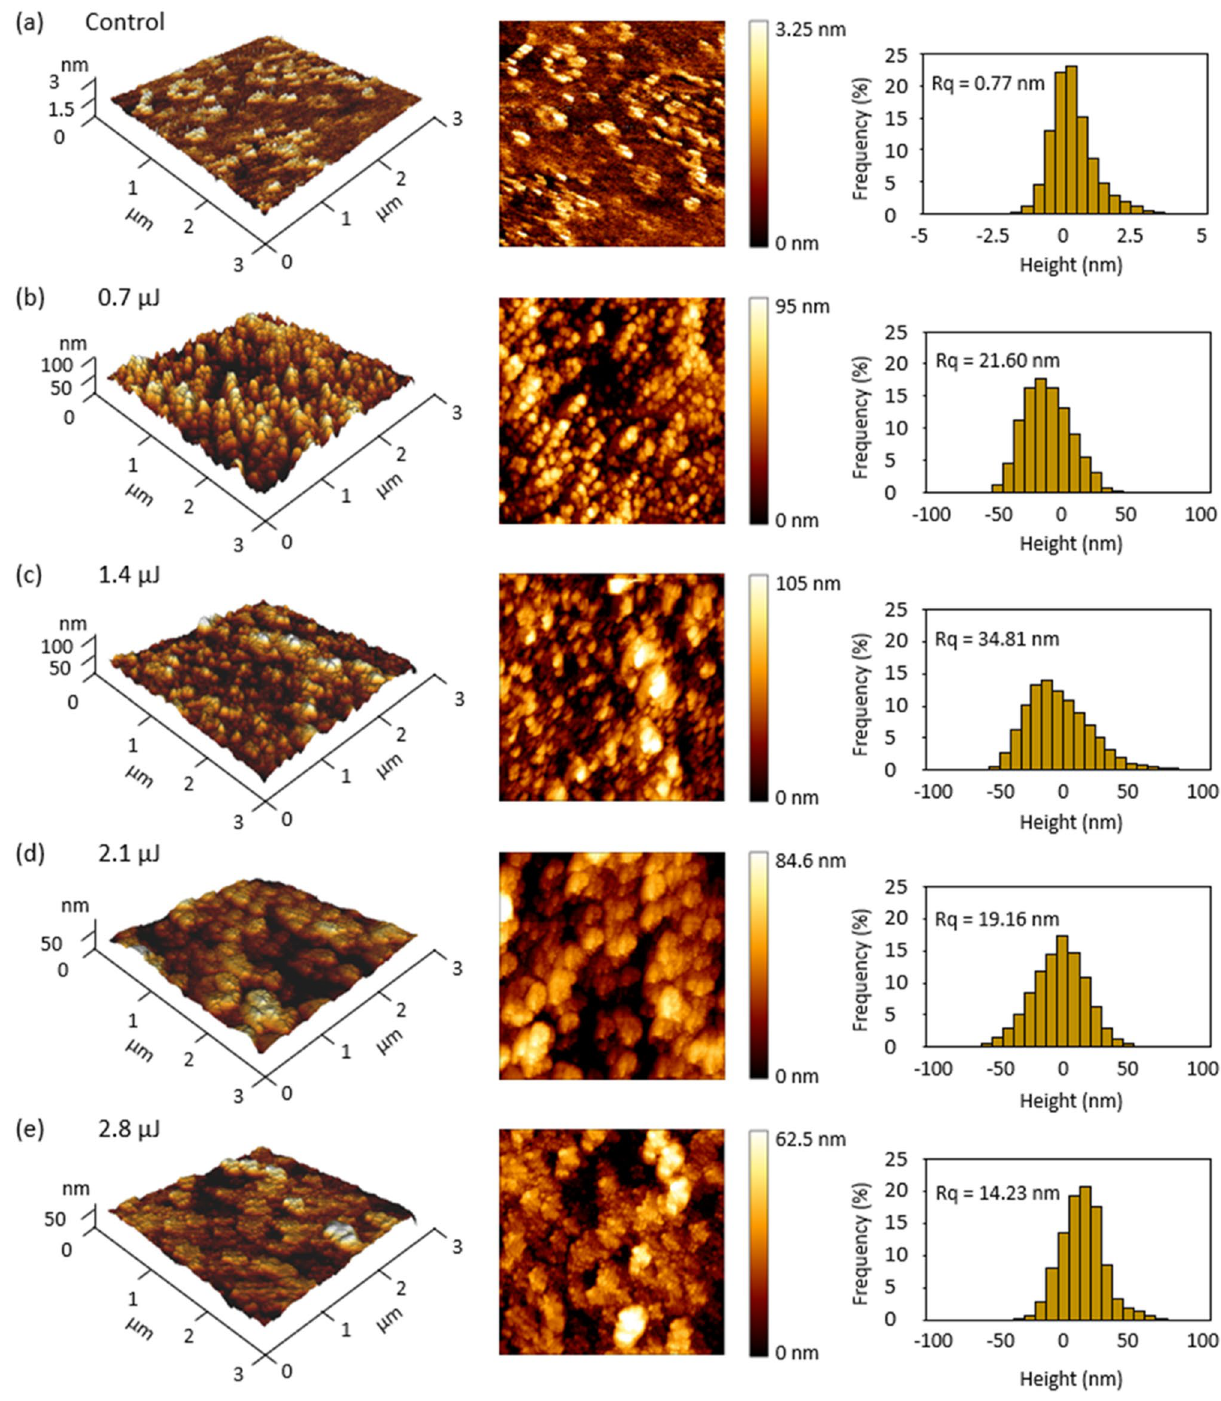
Figure 2. Surficial roughness detection by atomic force microscopy (AFM). ( a ) Control group. ( b – e ) Surrounding areas of the grooves engraved under pulse energies of ( b ) 0.7, ( c ) 1.4, ( d ) 2.1 and ( e ) 2.8 μJ/pulse. (We used the software JPK data processing 6.1 to create the